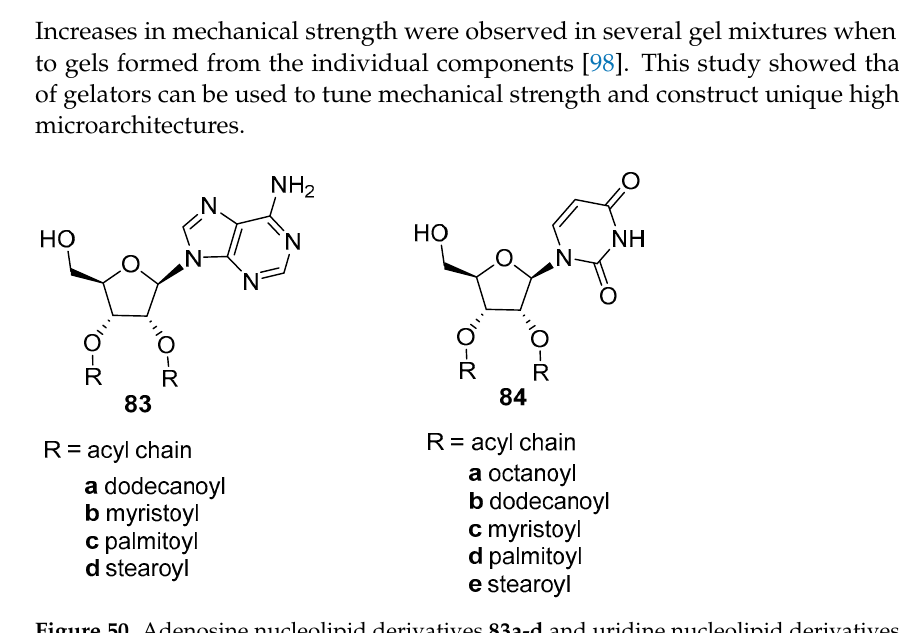
Figure 50. Adenosine nucleolipid derivatives 83a-d and uridine nucleolipid derivatives 84a – e [98].